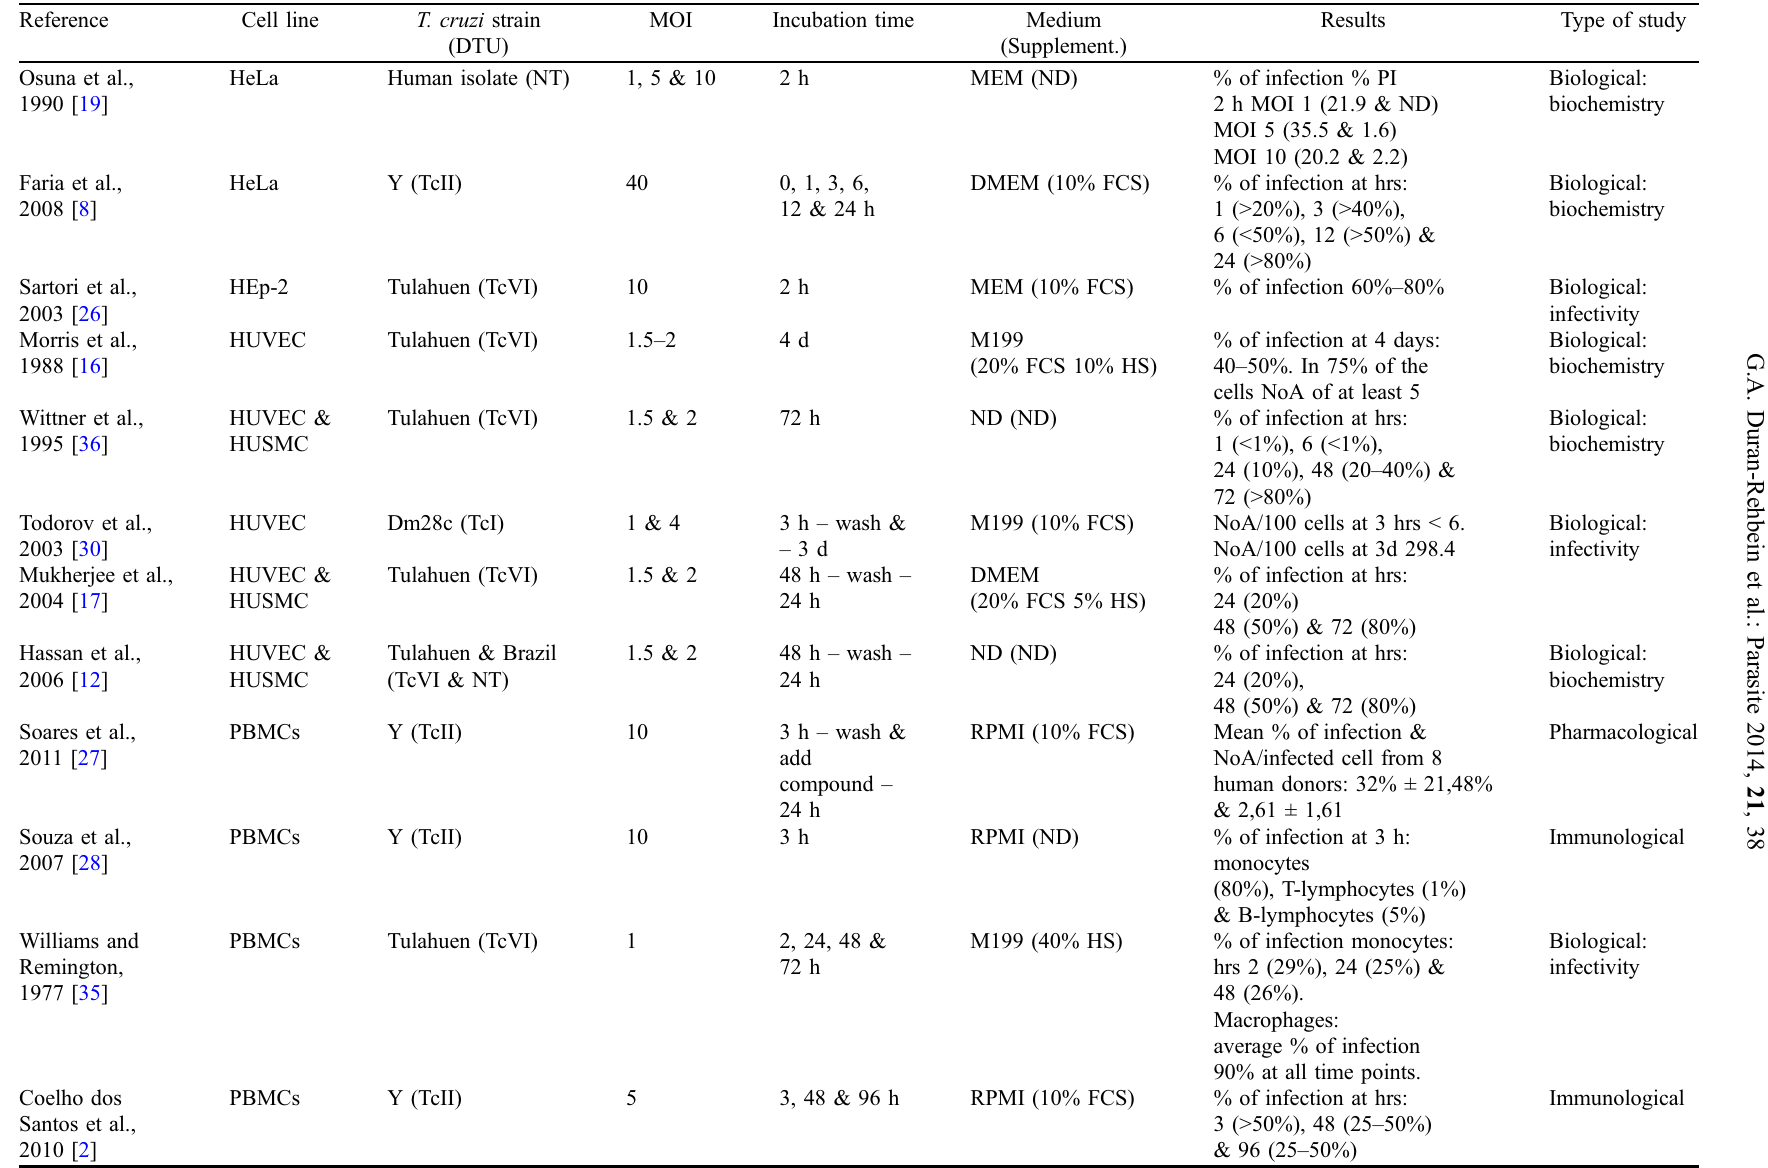
Table 1. Summary of data extracted from articles which met the selection